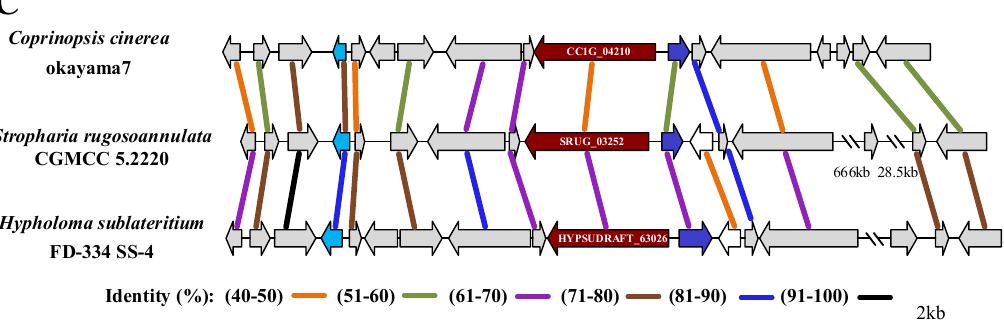
Figure 5. Comparative analysis of the siderophore gene clusters. ( A ) Phylogenetic analysis based on the amino acid sequences of the core genes of siderophore clusters. The red fonts in Figure 5A indicated the proteins of S. rugosoannulata. ( B ) Synteny analysis of the siderophore-encoding gene cluster predicted by Antismash in C. cinerea , S. rugosoannulata, and H. sublateritium . ( C ) Synteny analysis of the gene cluster responsible for coprinoferrin biosynthesis in C. cinerea , S. rugosoannulata, and H. sublateritium . The identity is based on the protein sequences. Gray arrowheads indicate the homologous genes, while white arrowheads indicate unique genes within the region analyzed and crimson arrowheads indicate the NRPS core genes. The sequence identity between the homologous proteins from the two fungi is shown by bold solid lines of different colors.